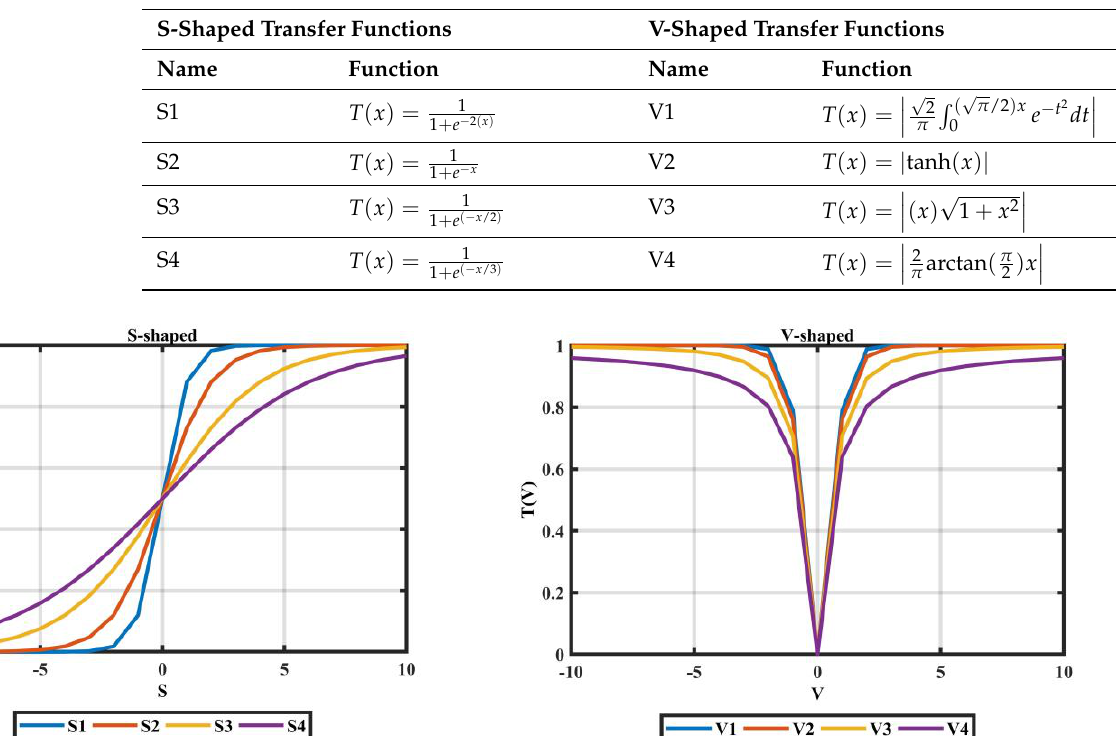
Table 1. List of transfer functions.